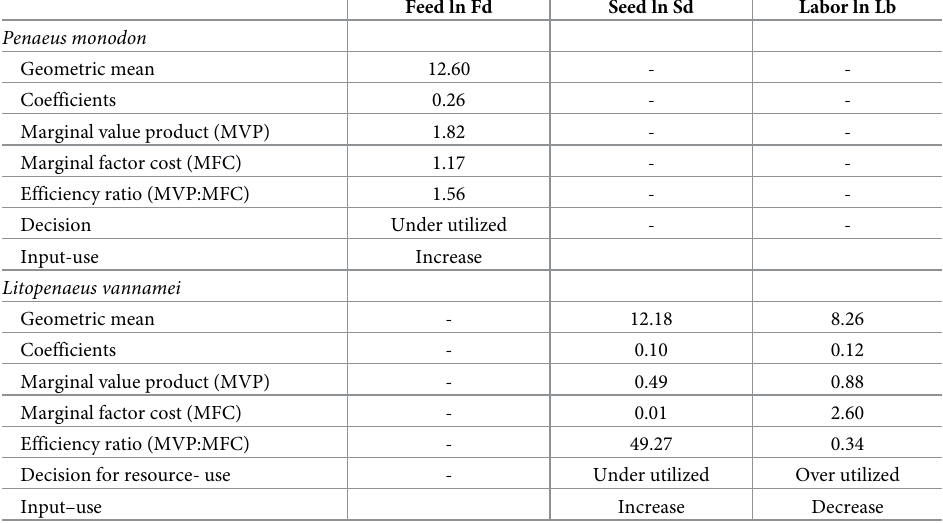
Table 9. Resource-use efficiency in shrimp